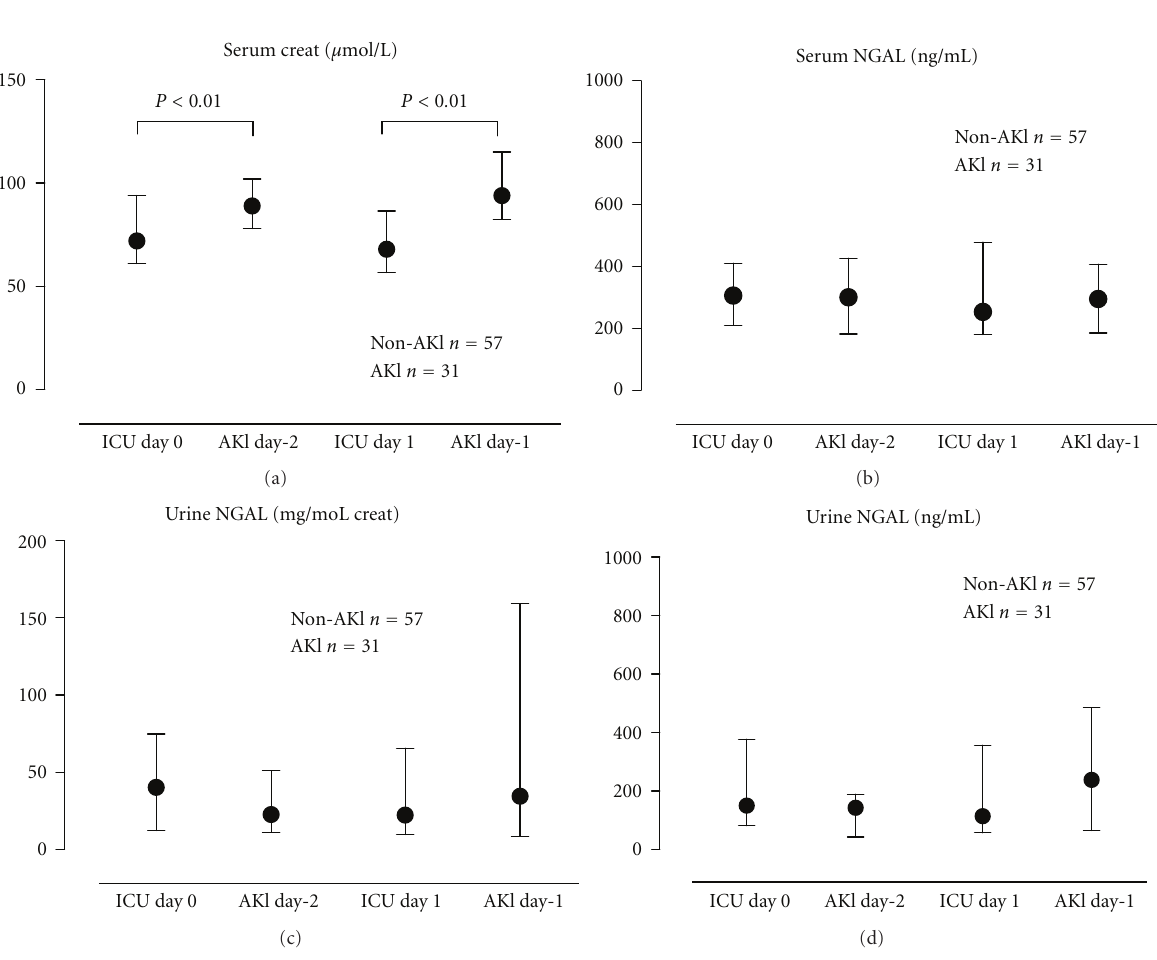
ROC curve 0.82 (CI 0.70–0.95). Constantin et al.